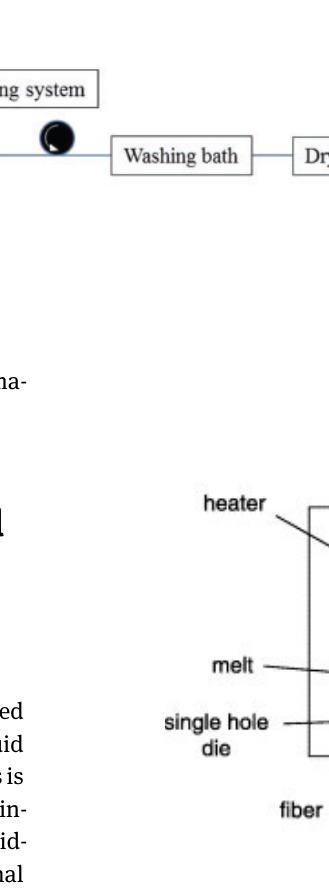
Figure 2: Melt-spinning process